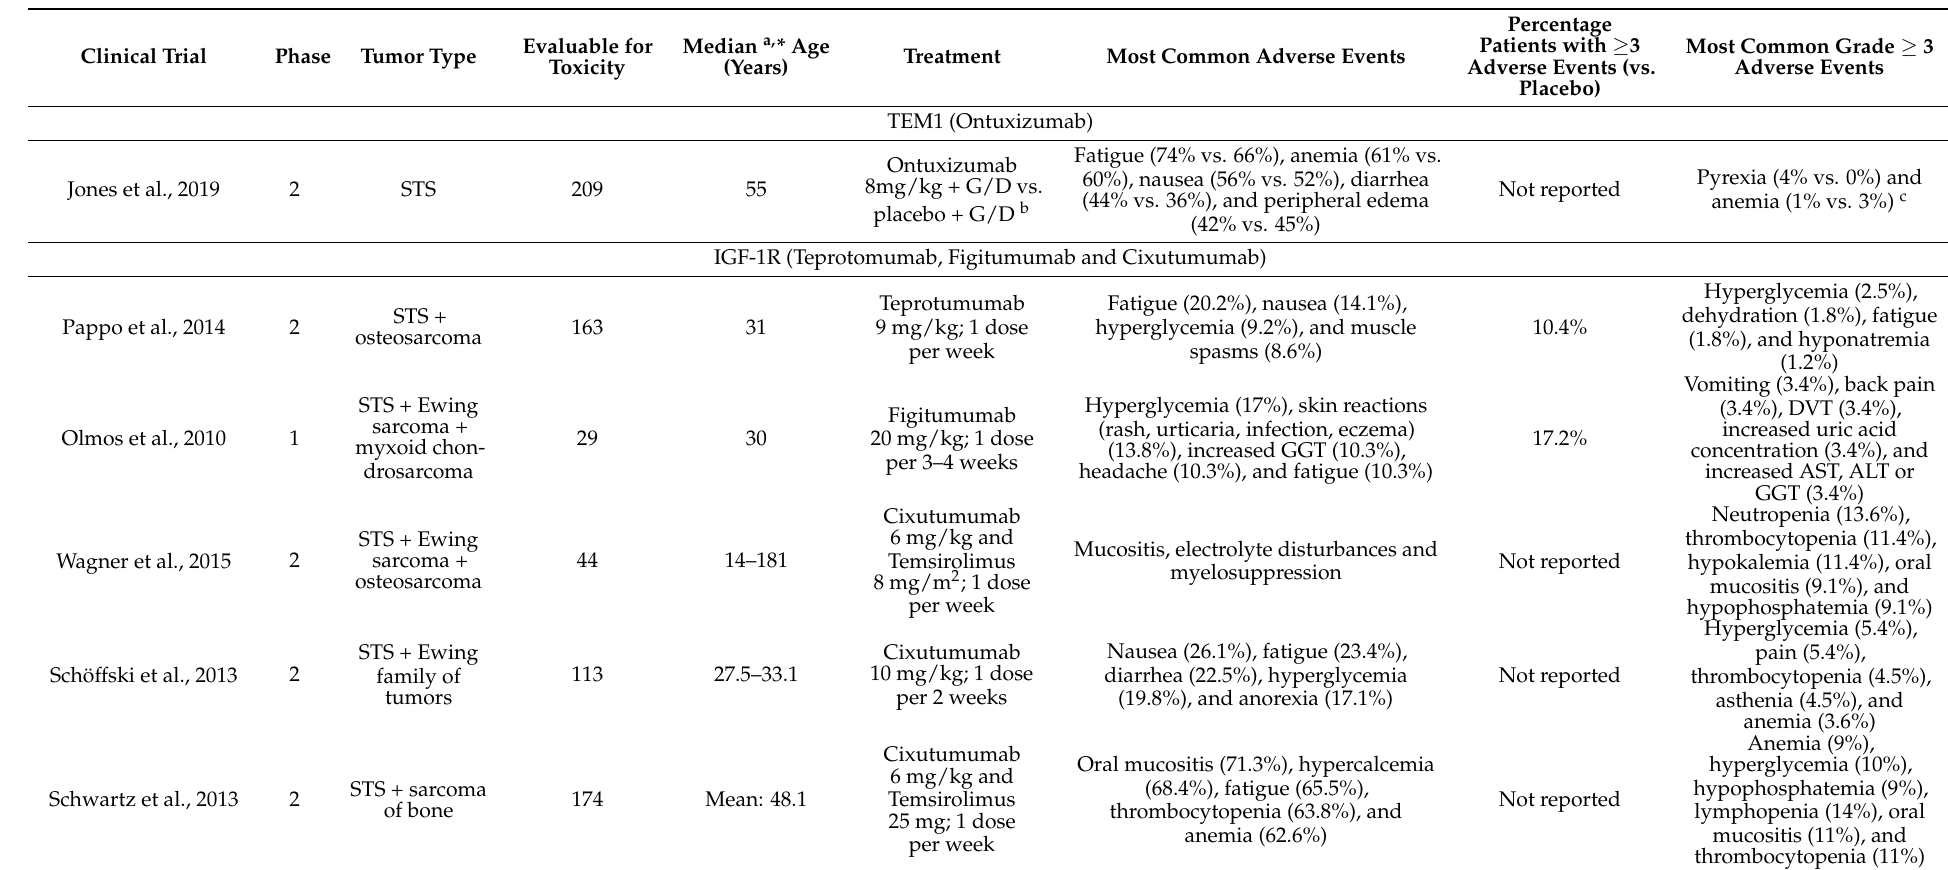
Table A2. Overview of the Toxicity of Clinically Available Monoclonal Antibodies in STS